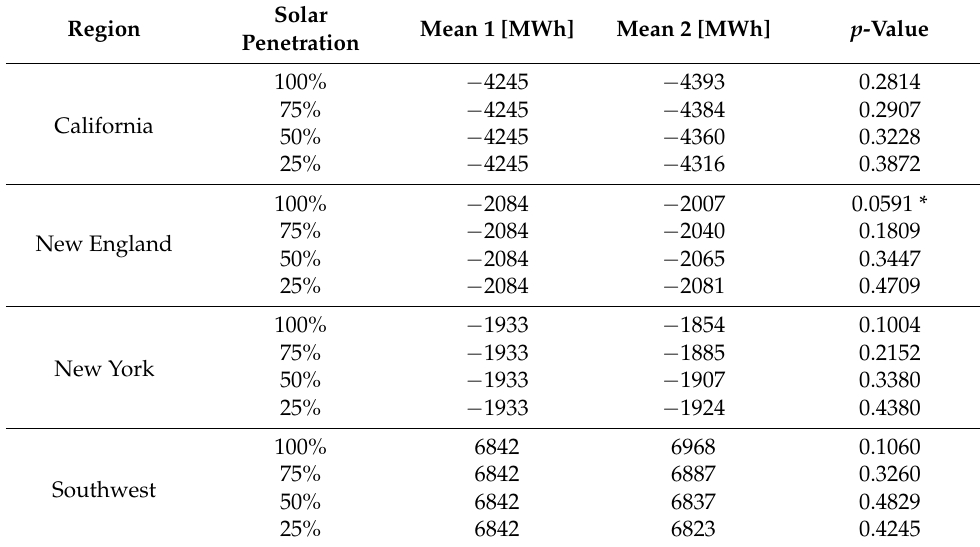
Table 11. Hypothesis 5— t -test results by region and level of solar penetration. Region